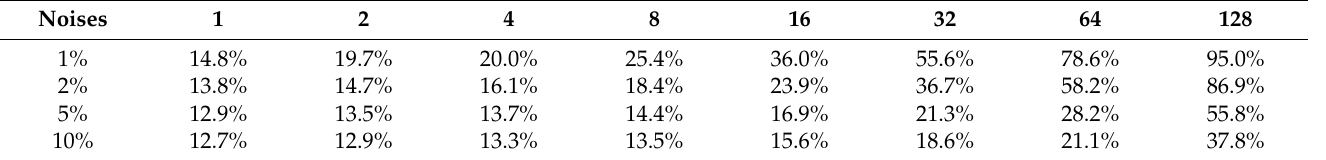
Table 5. Detection results of the time-considered CNN within the background with connected noises.